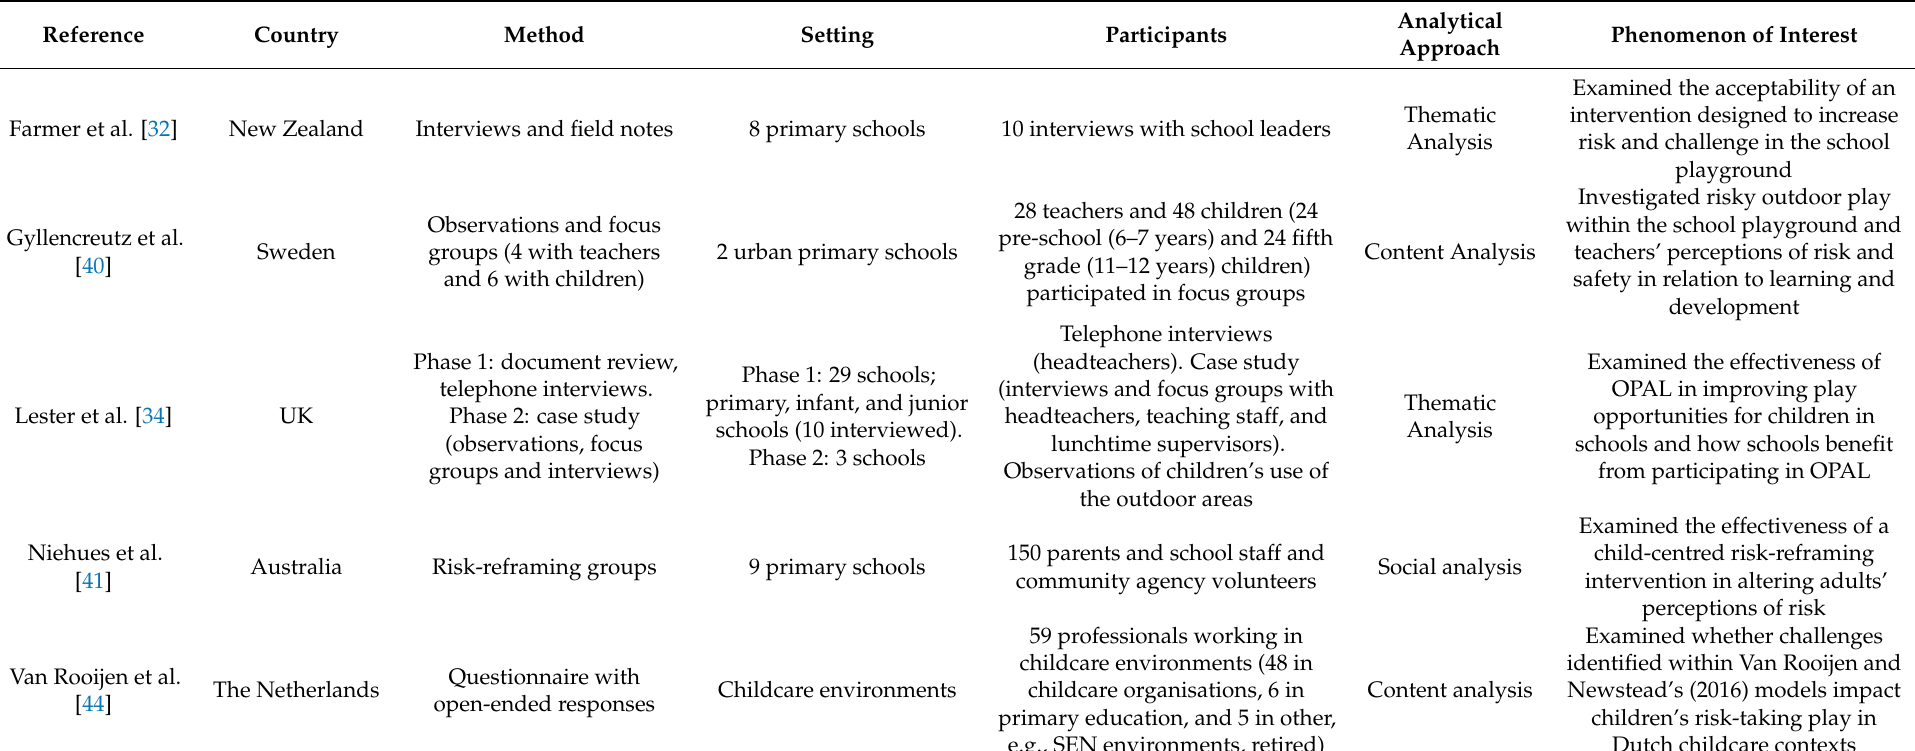
Table 8. Study characteristics of included articles, narrative